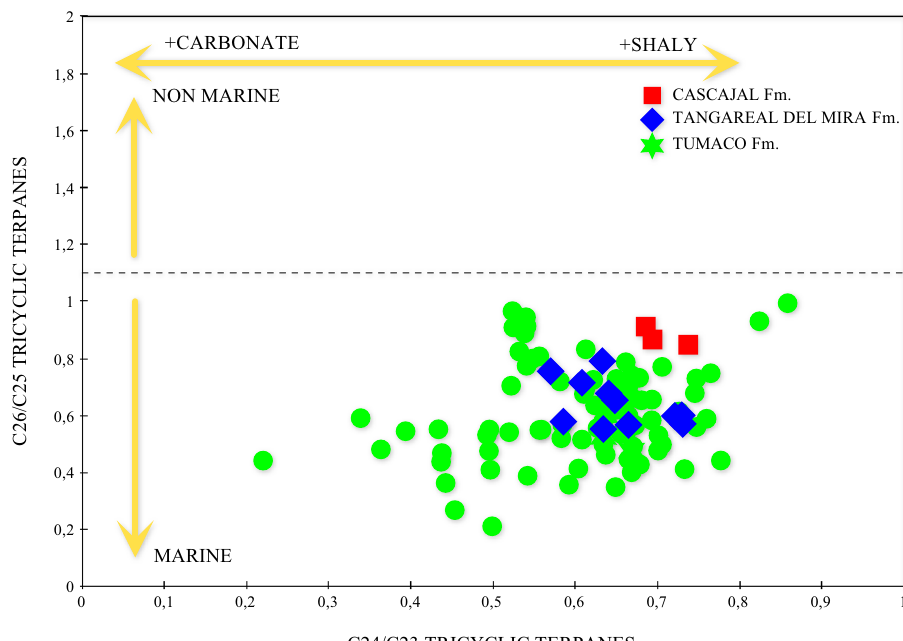
Fig. 13 Geochemical correla- tion between 26/25 tricyclic terpanes versus 24/23 tricyclic terpanes in the organic extracts from rock in Tumaco-1-ST-P, Tumaco basin,